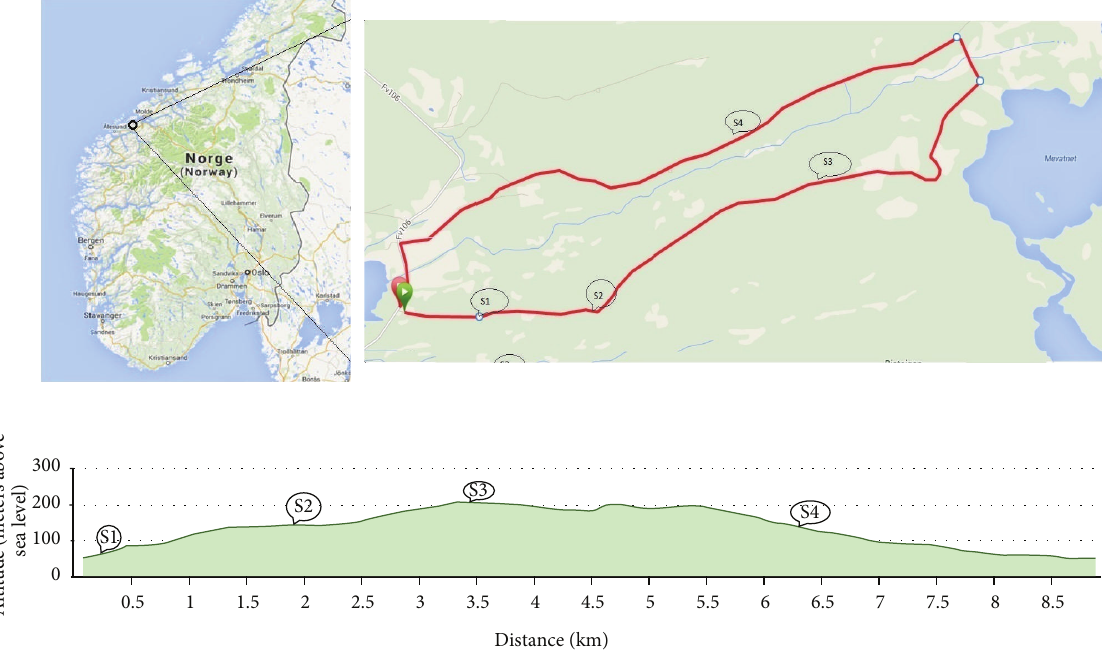
Figure 1: Map of the collection site. The map indicates the location site in northwest Norway and the tracking route used. The altitude of each collection site and the distance between the sites are indicated in the bottom part of the